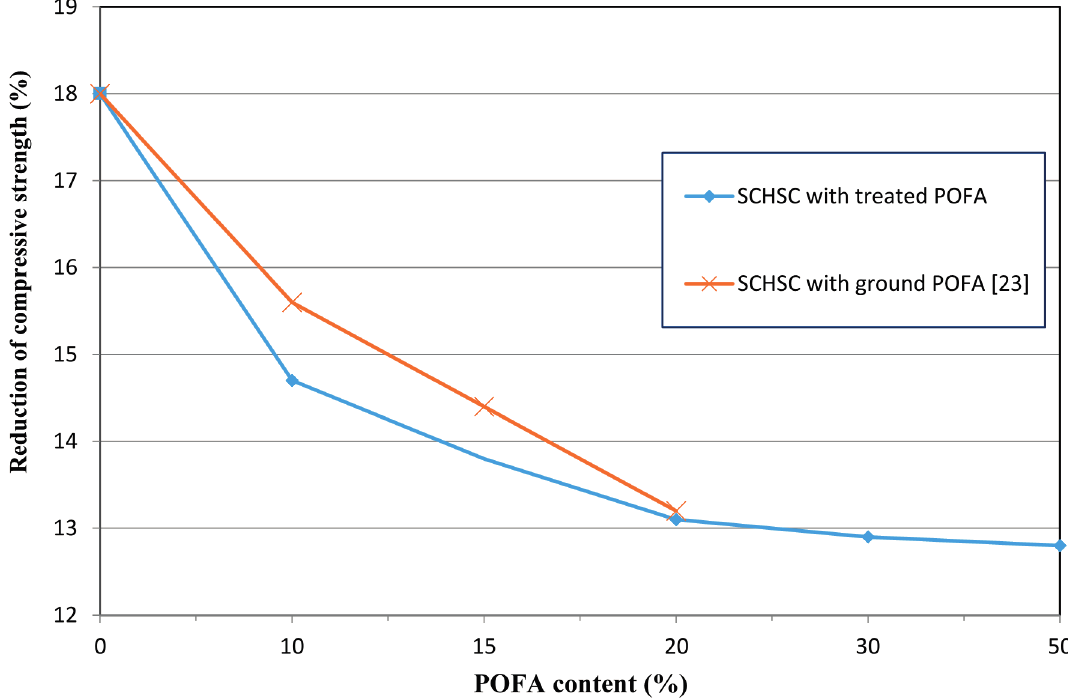
Figure 12. Relationship between reduction in compressive strength and treated POFA